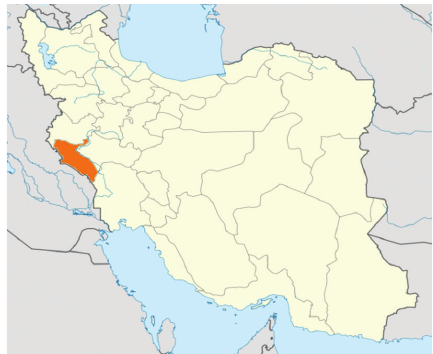
Figure 2: Map of study setting, Ilam,